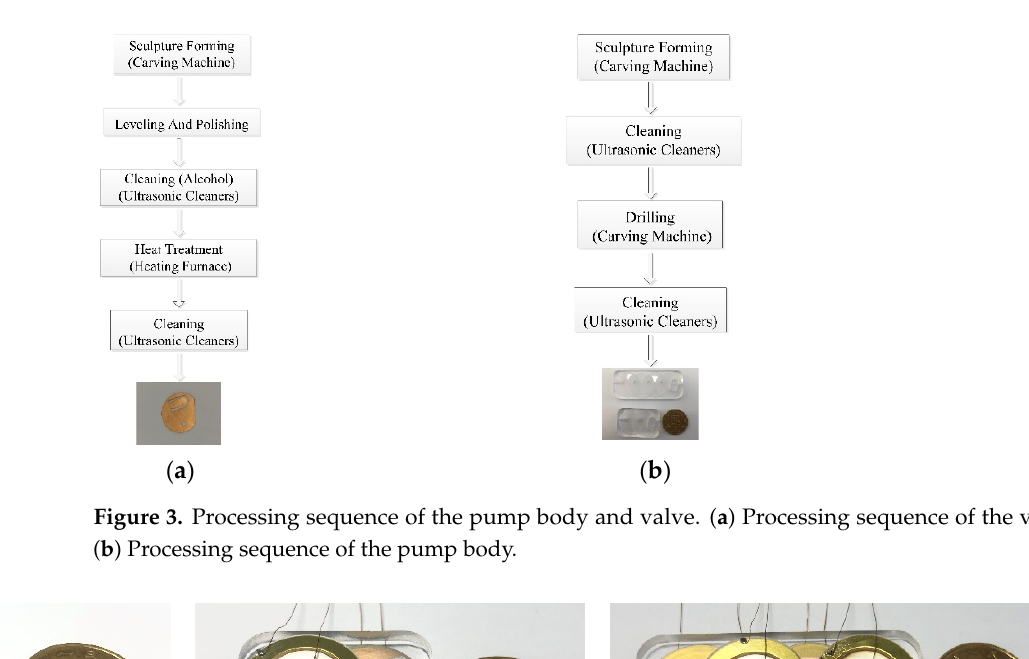
Figure 3. Processing sequence of the pump body and valve. ( a ) Processing sequence of the valve. ( b ) Processing sequence of the pump body.